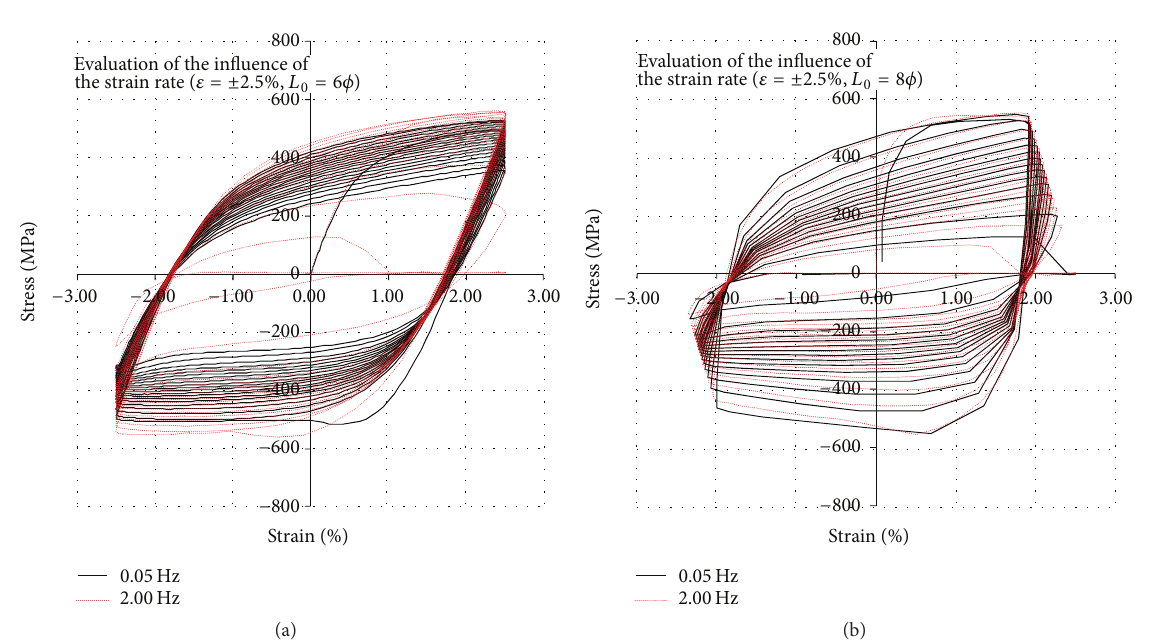
Figure 4: Stress-strain curve from LCF tests on specimens B450C-TEMP (prod. 2) 16 mm with frequency equal to 0.05 and 2.0 Hz.